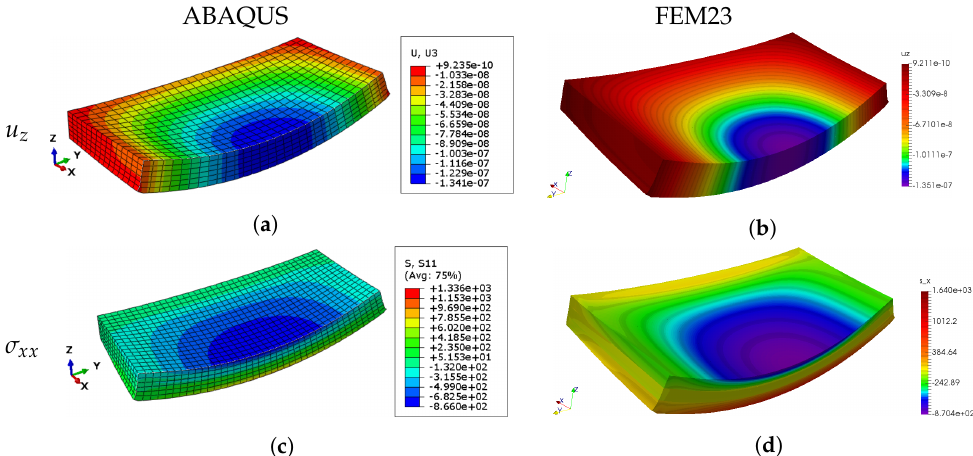
Figure 6. Example 1: The maps of deflection u z ( a , b ) and the stress component σ xx ( c , d ) presented on the half of the deformed plate obtained by 3D FEM and FEM23 for the bs boundary